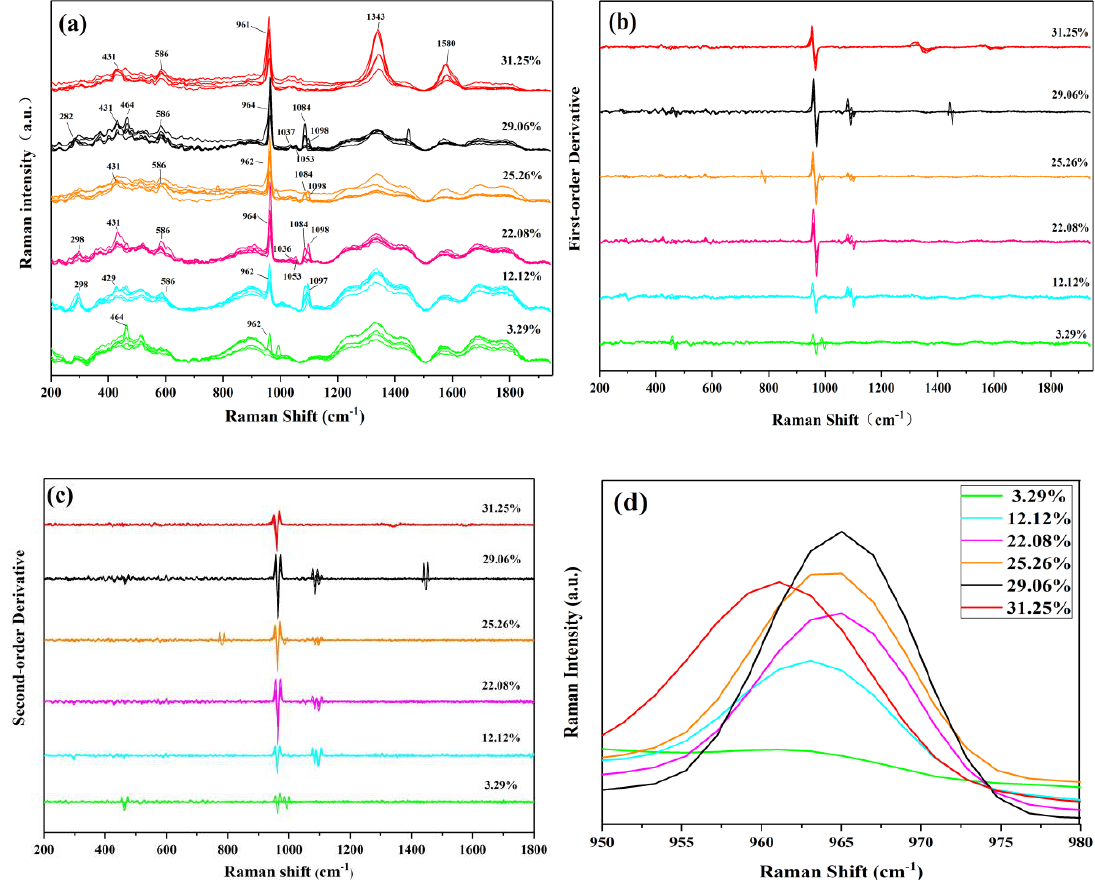
Figure 1. ( a ) Raman spectra of the six phosphorite samples after Savitzky–Golay (SG) smoothing and adaptive iteratively reweighted penalized least squares (airPLS) baseline correction. ( b ) First derivatives of the Raman spectra in ( a ). ( c ) Second derivatives of the Raman spectra in ( a ). ( d ) Averaged Raman spectra of the six phosphorite samples in the zoomed spectral range of 950–980 cm − 1 . For each sample, the averaged spectrum was obtained by averaging the spectra of the 10 pellets.